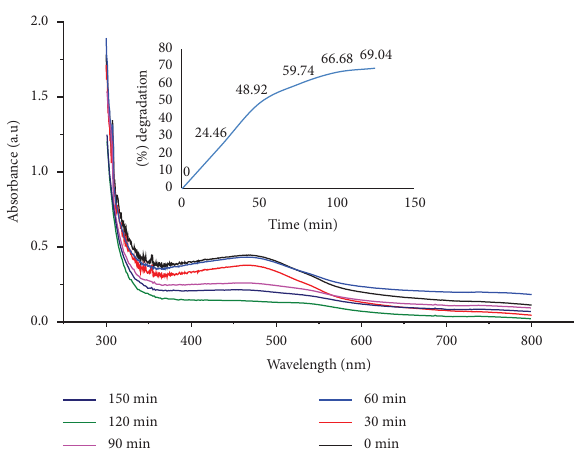
Figure 8: Photocatalytic degradation of methyl orange using cellulose/MoS